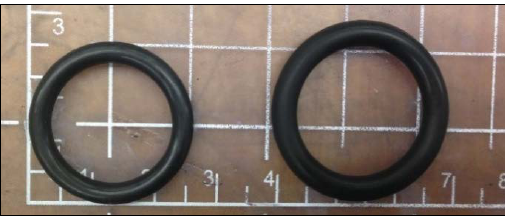
Figure 4. Chemical Pre-strain. Left o-ring is without treatment, right o-ring with treatment in solvent for 15 min.